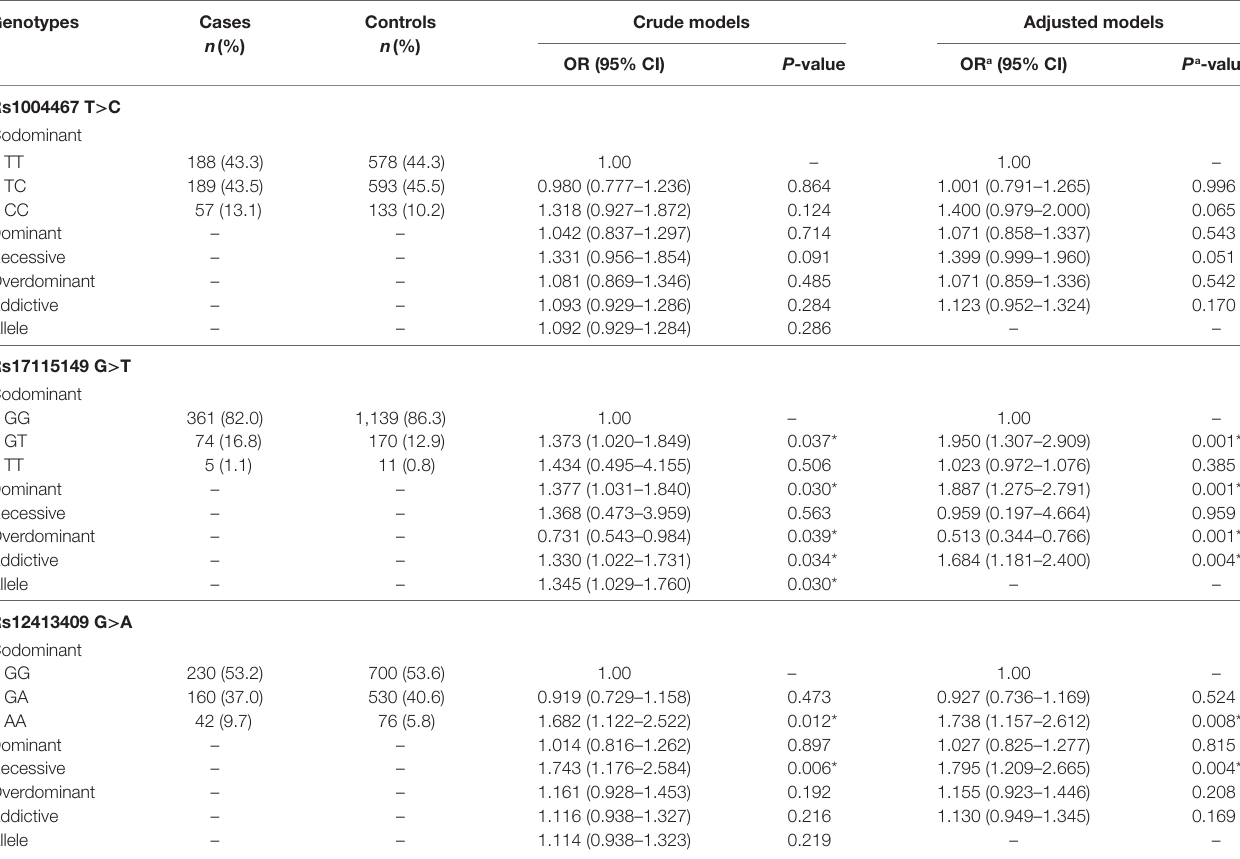
TaBle 2 | Association of three genotyped single nucleotide polymorphisms with type 2 diabetes mellitus in the Han Chinese